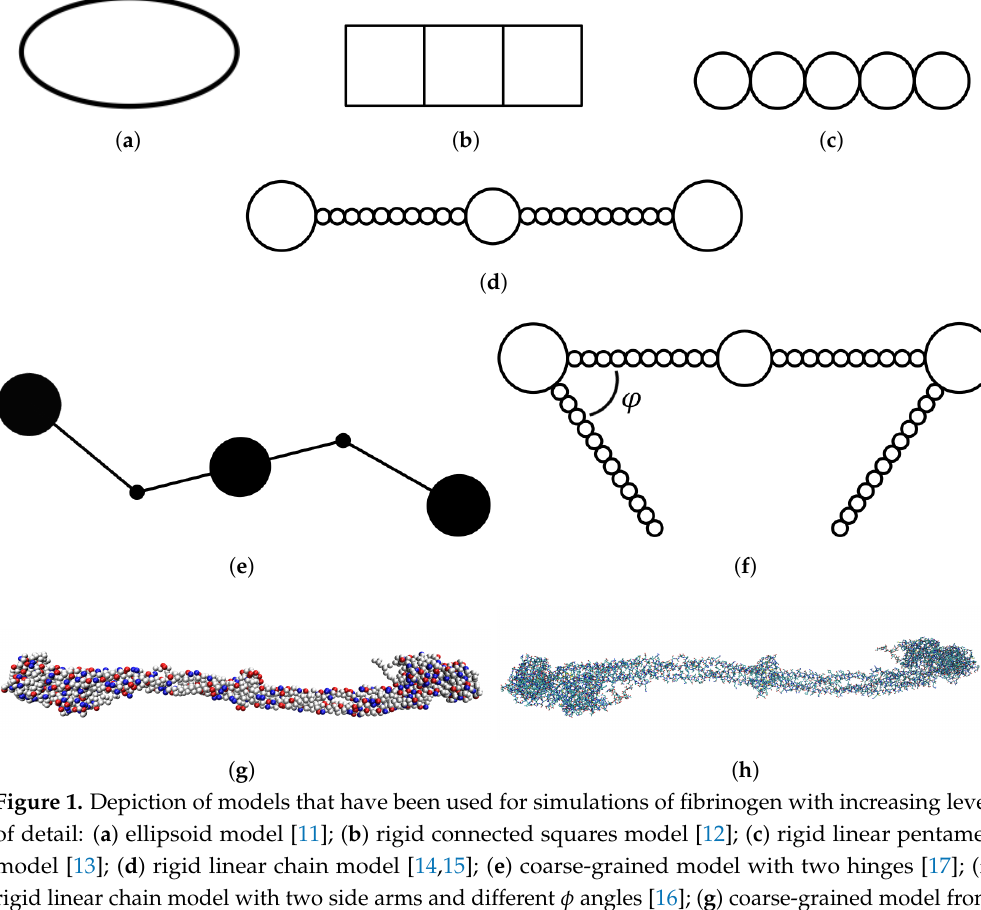
Figure 1. Depiction of models that have been used for simulations of fibrinogen with increasing level of detail: ( a ) ellipsoid model [11]; ( b ) rigid connected squares model [12]; ( c ) rigid linear pentamer model [13]; ( d ) rigid linear chain model [14,15]; ( e ) coarse-grained model with two hinges [17]; ( f ) rigid linear chain model with two side arms and different φ angles [16]; ( g ) coarse-grained model from crystal structure, either completely rigid (this work [20]) or somewhat flexible [19]; and ( h ) atomistic model from crystal structure